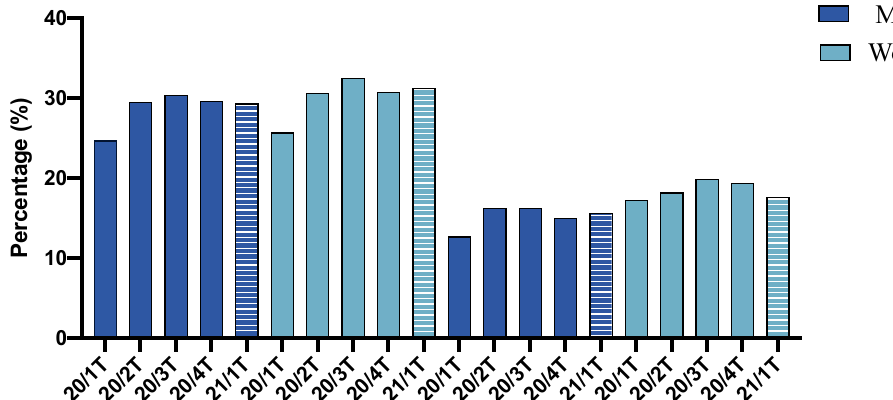
Figure 10. Unemployment rate by terms, Spain 2020–1st trimester of 2021. Source: Our own elaboration through EPA microdata.